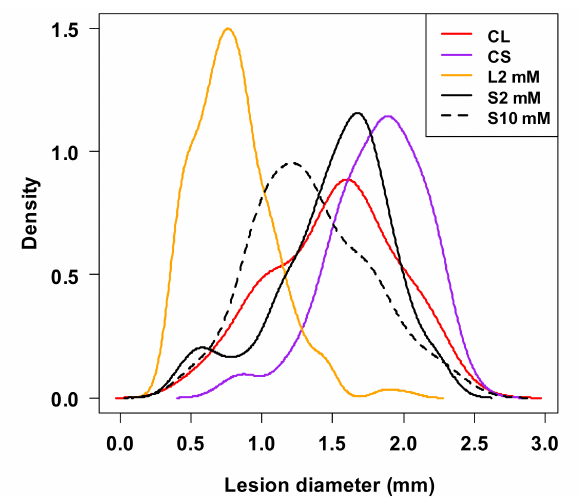
Figure 5. Effect of local (CL and L2) and systemic (CS, S2 and S10) pipecolic acid ( D - L -Pip) treatments on TMV lesion size distribution by using Kernel density estimation [31,32] (2 days after Pip infiltration). L2, S2 and S10: local (L, leaf 6) and systemic (S, leaf 7) effects of 2 and 10 mM D - L -Pip treatments as compared to corresponding local control (CL) and systemic control (CS) leaves (triplicate per treatments). In a multiple comparison test [31], both concentration of Pip treatment resulted in significant decrease of TMV lesion size. The highest difference was caused by local treatment (L2). The effect of systemic treatment with 10 mM Pip was more pronounced (and significantly different) than with 2 mM